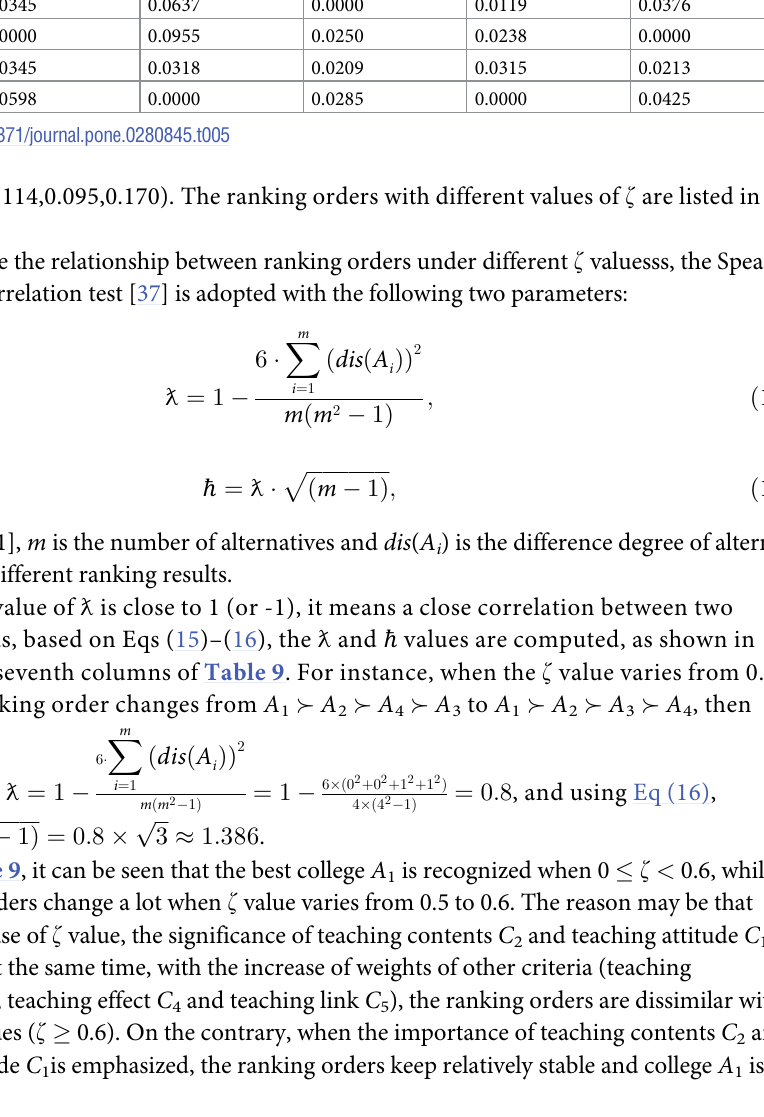
Table 5. Real assessment matrix R .